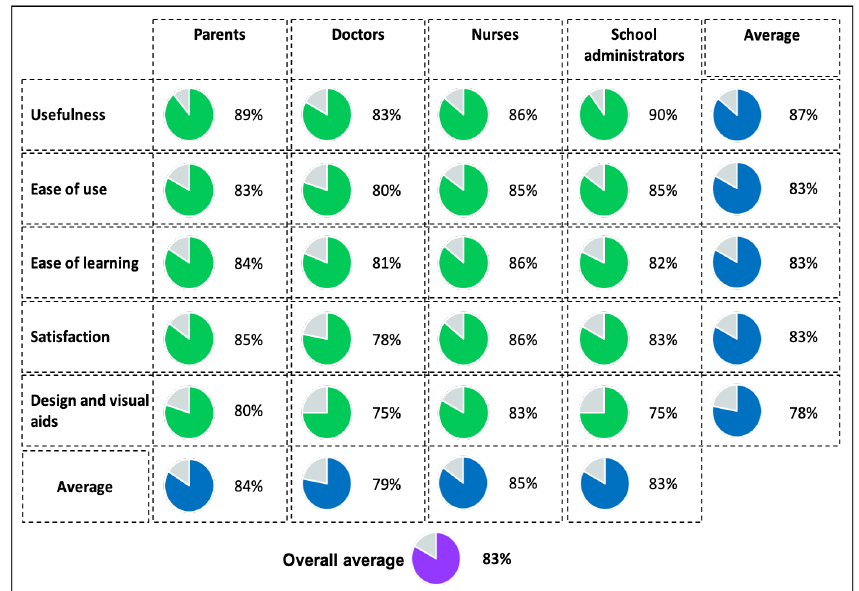
Figure 9: Weighted scores per user perception category and stakeholder